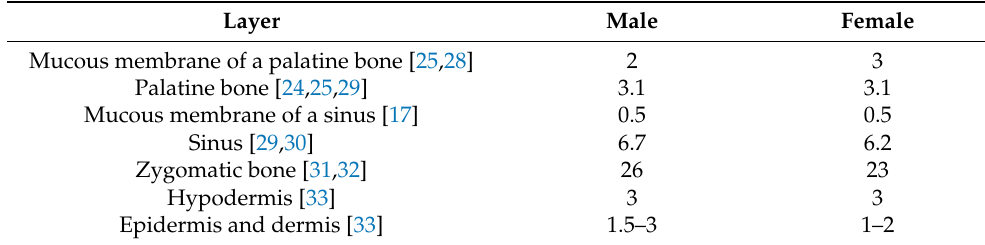
Table 2. The thickness of the simulated layers,